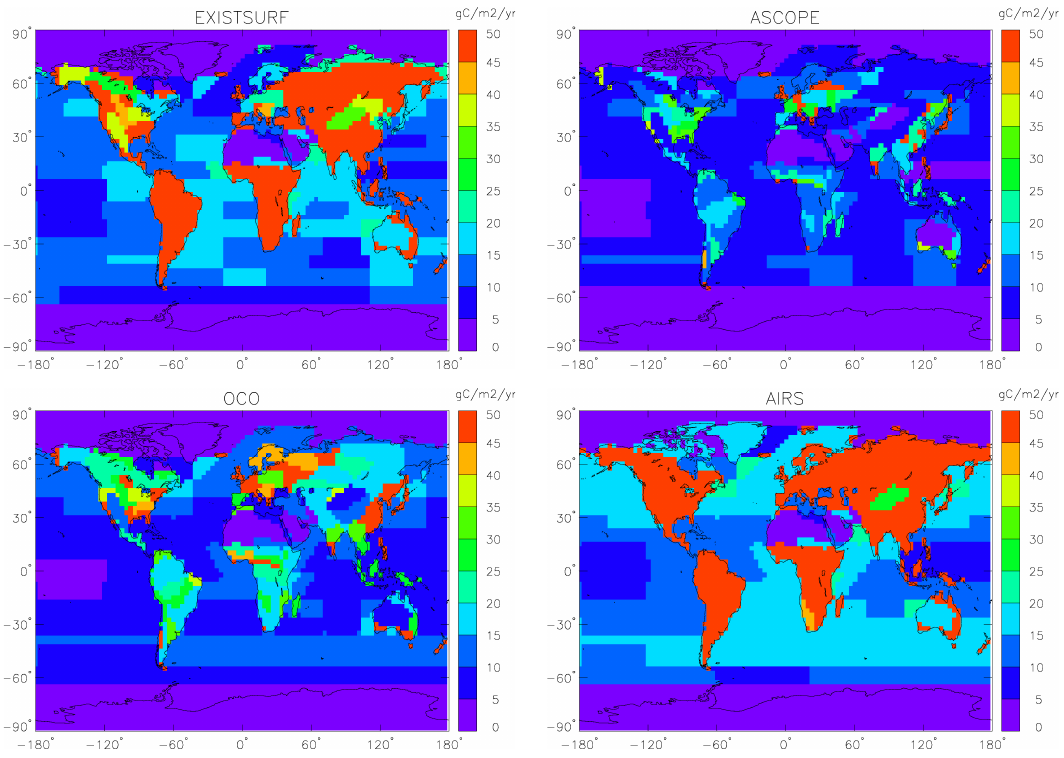
Fig. 6. Annual posterior uncertainty in gCm − 2 yr − 1 for the (a) existing surface network (EXISTSURF) (b) A-SCOPE-2.0 (c) OCO and (d) AIRS.